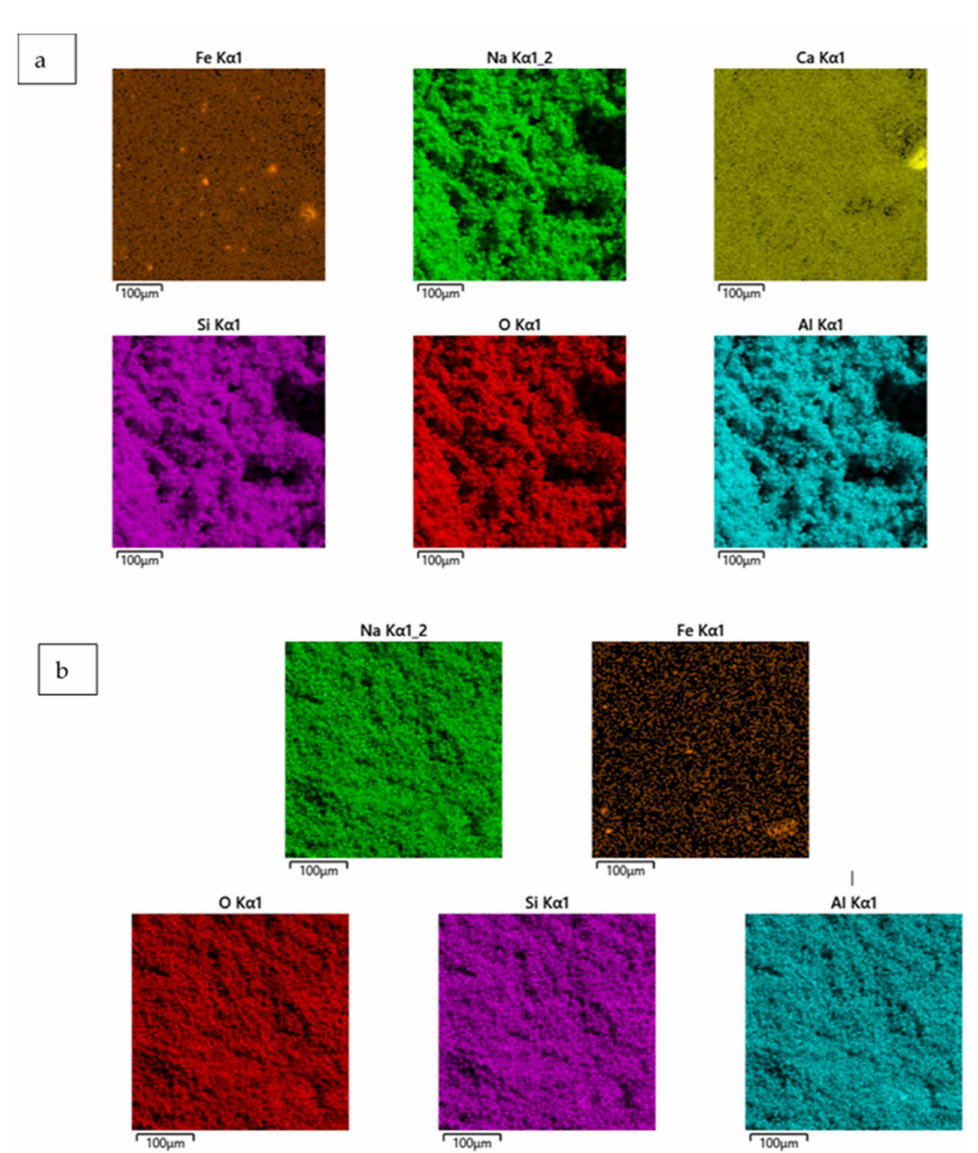
Figure 10. Mapping of the chemical elements—( a ) Fresh sample, ( b ) Bleached